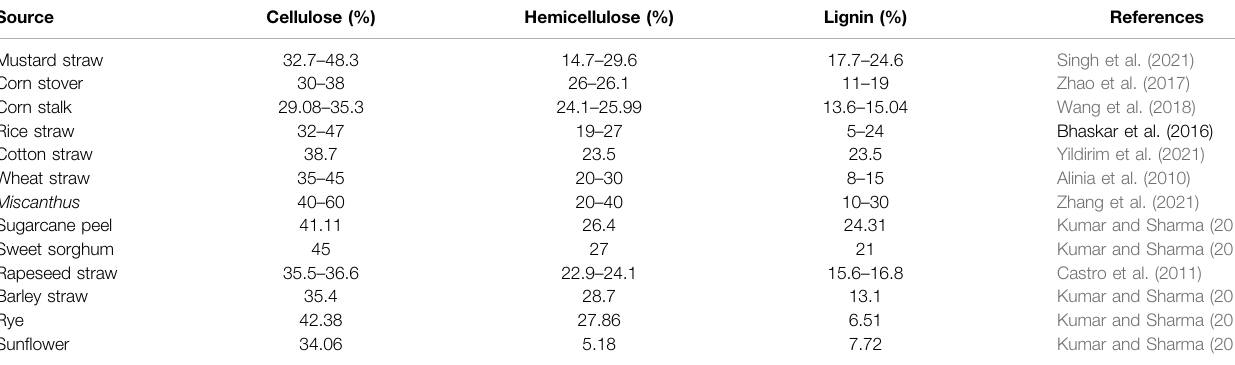
TABLE 1 | Chemical components of diverse straw biomass (% dry